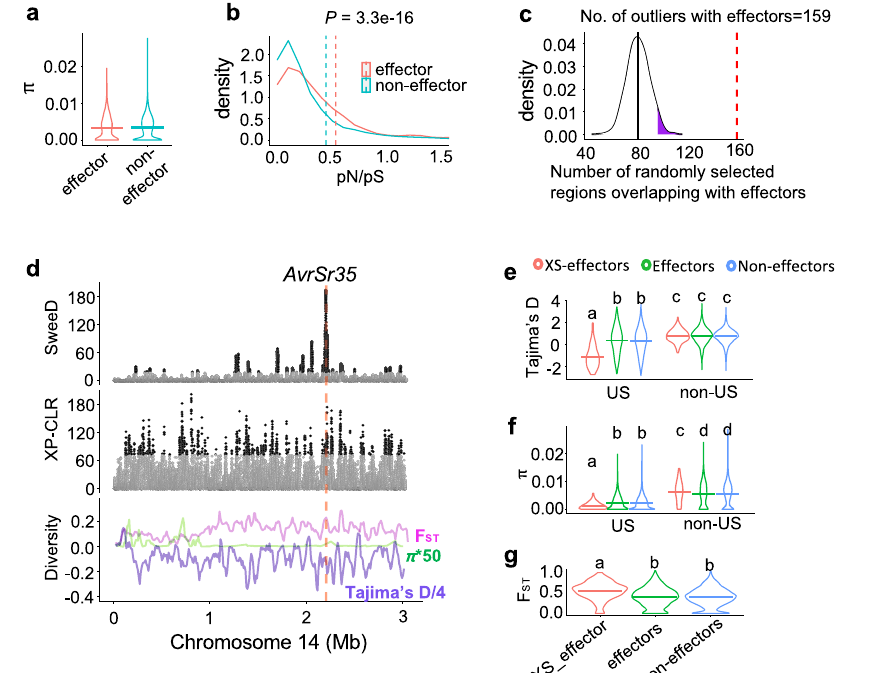
Fig. 3 | The regions of the Pgt genome showing evidence of adaptive selection are enriched for predicted effector-encoding genes and overlap with aviru- lence factors. a Violin plots of genetic diversity π for effector/non-effectors (Two- sided Mann – Whitney U -test p value=0.016). b Density plot of gene-based pN/pS ratio calculated for effector and non-effector-encoding genes (Two-sided Mann – Whitney U -test p value=3.3e-16). The mean and SEM (standard error of the mean) for effectors is 0.54 and 0.05, mean and SEM for non-effectors is 0.45 and 0.024. Outliers of pN/pS greater than 1.5 are not displayed. c Density plot showing the numberofgenomic windows overlapping with effectorsinthe random sample of genomic windows. Random sampling was performed 1000 times. The 95th percentile of the density plot is highlighted in purple. The number of selective sweepoutlierwindowsoverlappingwitheffector-encodinggenes(159)isshownby a vertical dashed line.A selective sweep isperformed using 15 isolates from the US